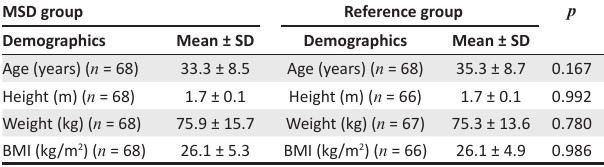
TABLE 1: Group demographics and anthropometrics ( n = 136). MSD group Reference group